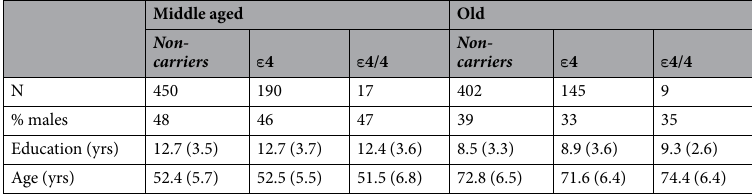
Table 1. Demographic characteristics stratified by APOE genotype.